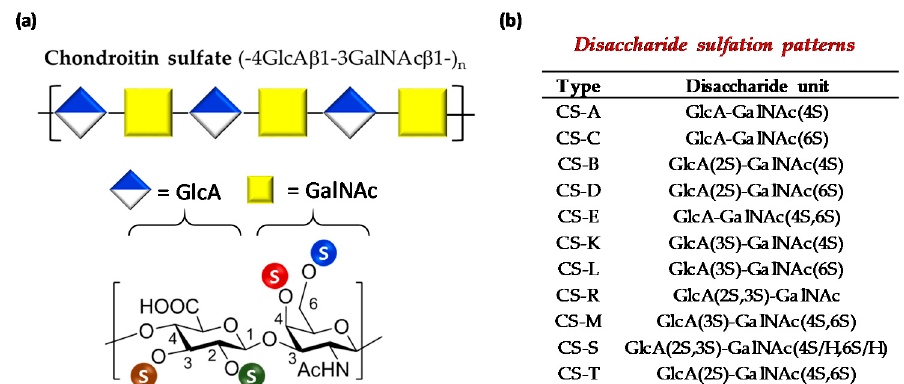
Figure 1. ( a ) Structure of chondroitin sulfate chains (top); chemical structure of typical disaccharide units found in CS chains (bottom). An “S” enclosed by circles indicates the various positions that can be esterified by sulfates. ( b ) Disaccharide sulfation patterns of natural CSs.